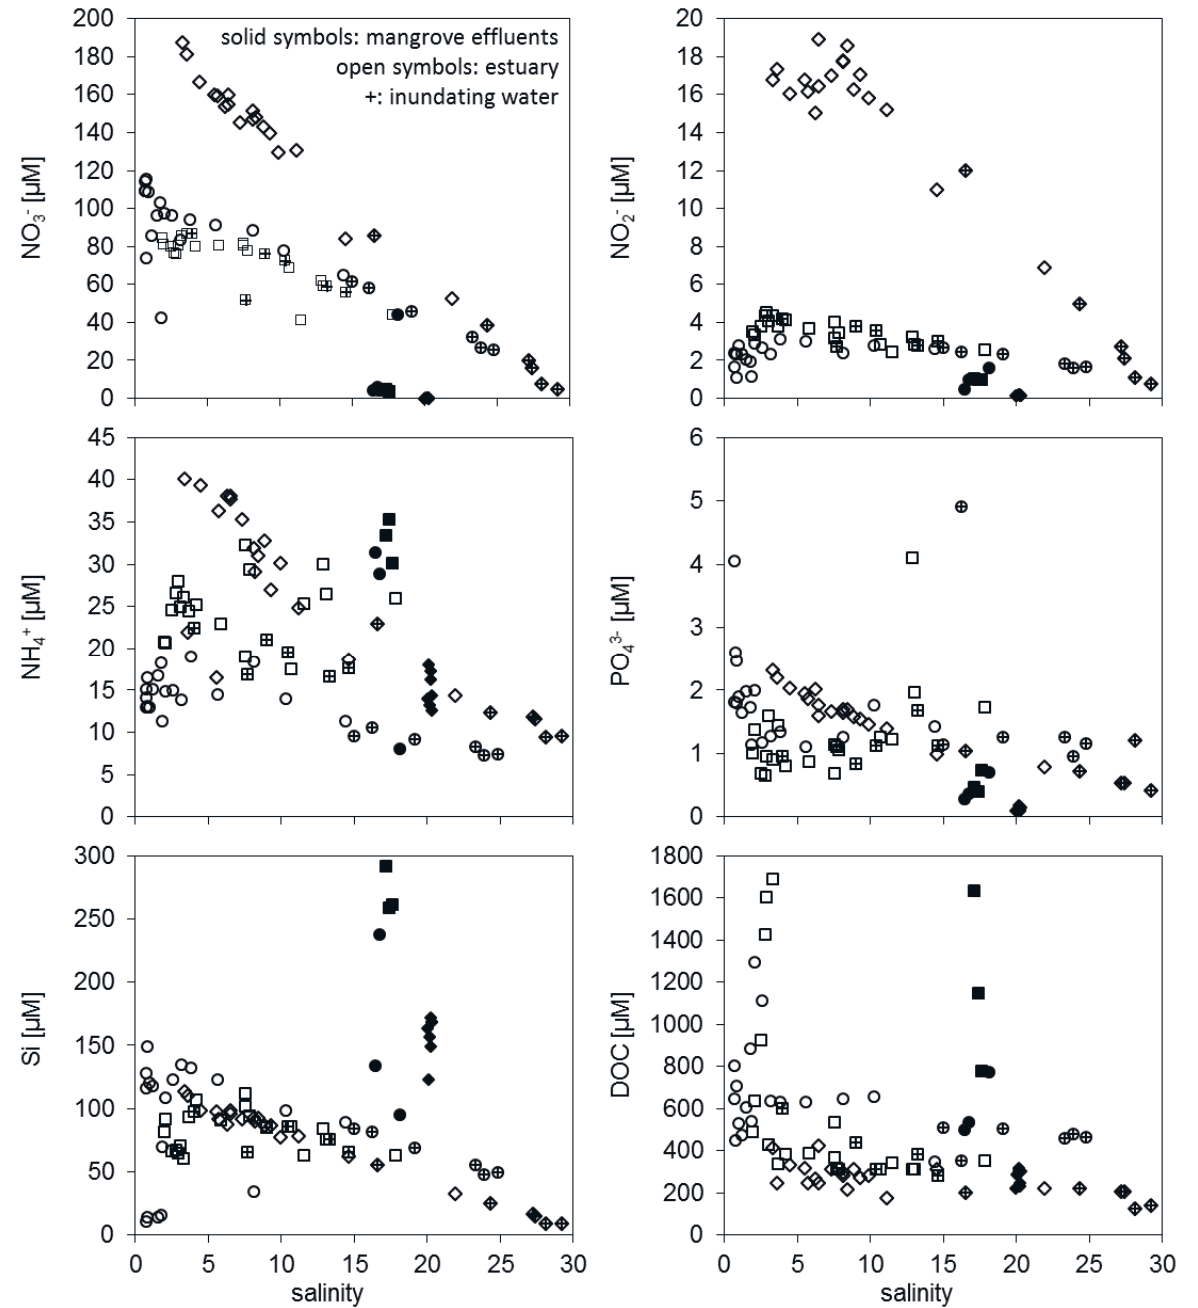
Figure 2. Concentrations of dissolved inorganic nutrients and dissolved organic carbon (DOC) from 24 h estuarine tidal cycles ( open symbols ) and from mangrove effluents ( solid symbols ) plotted against salinity. Diamonds are from spring tide of March 2011, while circles and squares are from spring and neap tides of September 2011, respectively. Values of high tide samples inundating mangrove sediments are marked